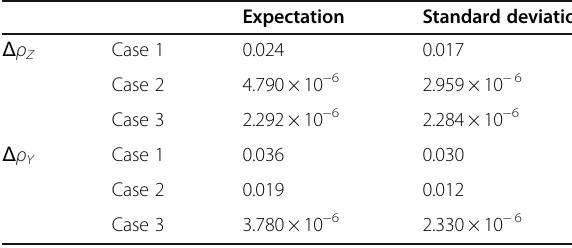
Table 1 Error analysis of correlation control